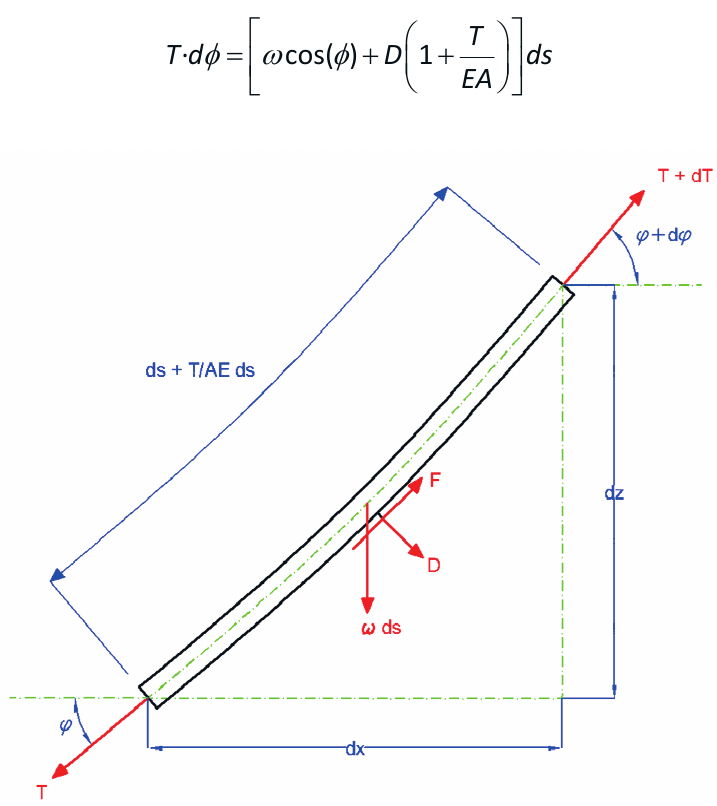
Figure 5. Segment line forces scheme.